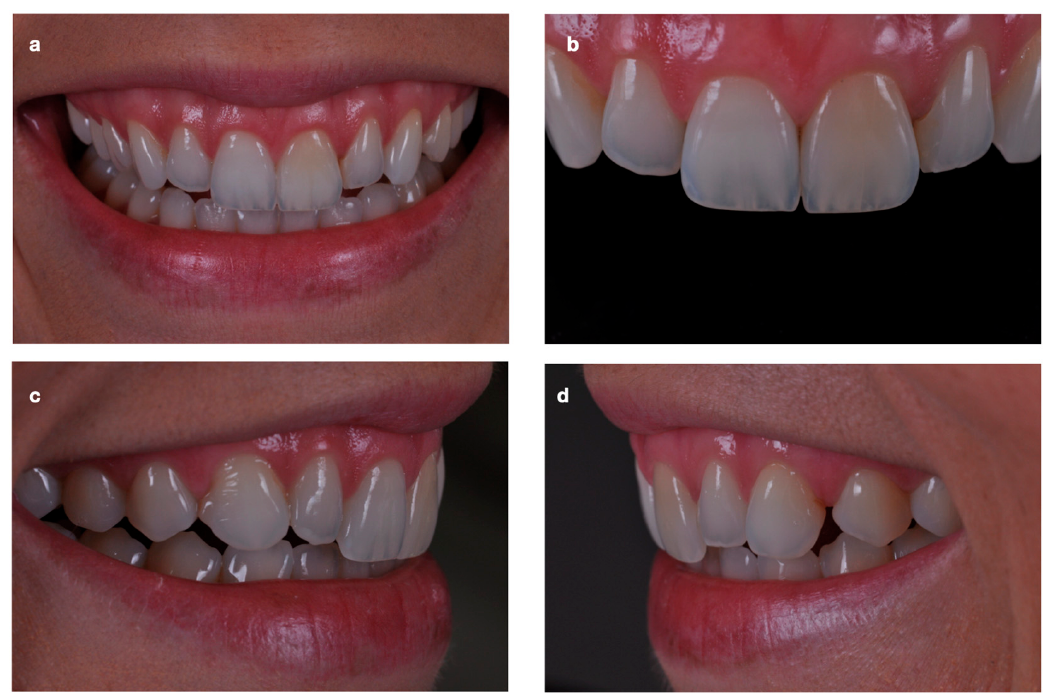
Figure 1. ( a ) Facial preoperative view of the smile. ( b ) Intraoral view revealing the darkening of the upper left central incisor tooth. The incisal aspect of the upper left central incisor is intact, with optic and morphological properties homologous to the upper right central incisor. ( c ) Lateral view showing composite resin restoration to close a diastema between the upper right canine and first upper right premolar. ( d ) Lateral view showing diastema between the upper left canine and first upper left premolar.